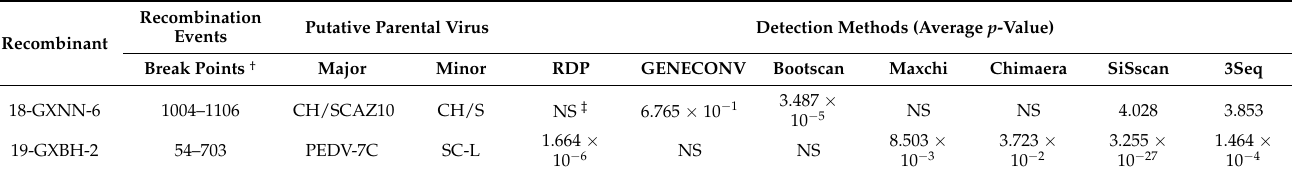
Table 3. Characteristics of on the recombination events